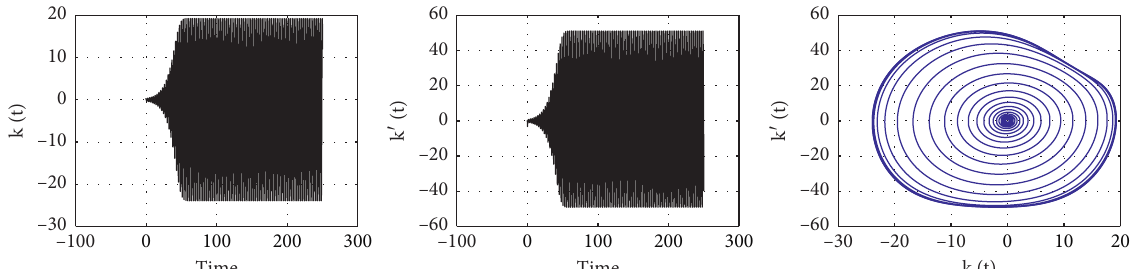
Figure 14: Solutions and phase trajectories at a � 0.125, q � 0.75, and τ �